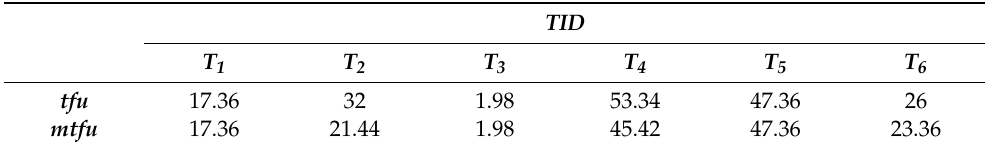
Table 4. The mtfu and tfu values for each transaction.